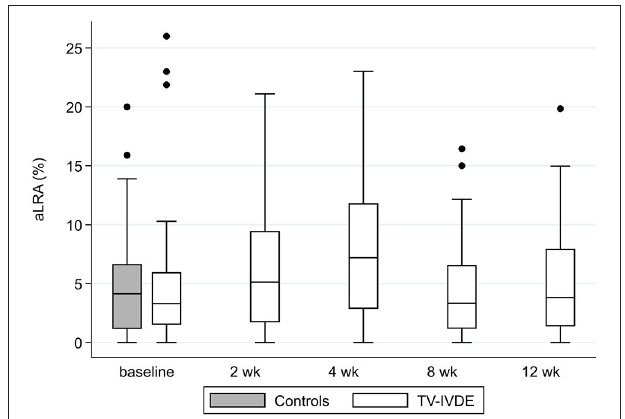
FIGURE 1 | PL% in normal and TL-IVDE dogs at baseline and across study visits. PL%: pelvic limb static weight distribution as a percentage of total body weight.